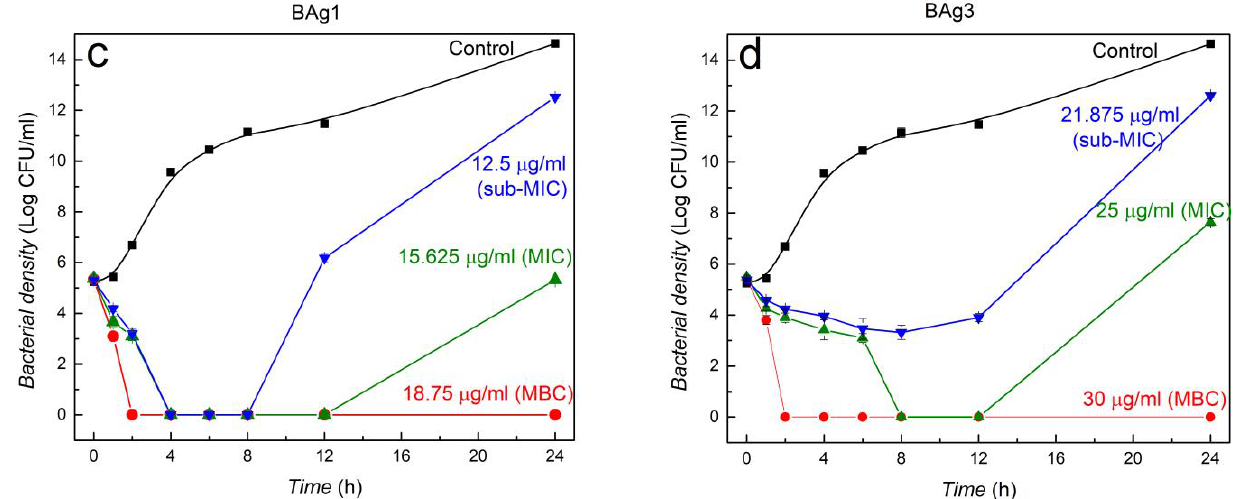
Figure 5. Time–kill curves for E. coli exposed to four different nanocomposites at different concen- trations. Nanocomposites synthesized after 120 minutes’ reaction time using precursors BW9 at